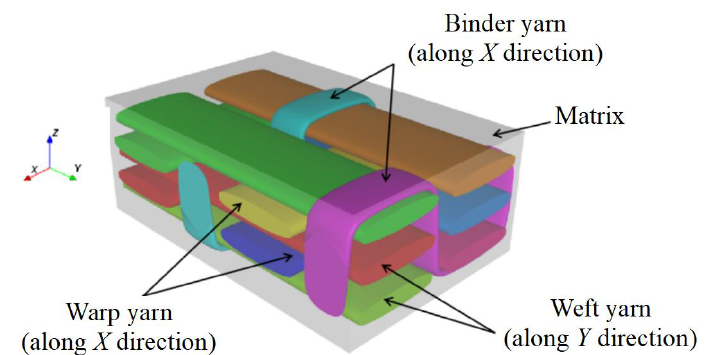
Figure 3. The unit cell of 3D textile composite plate.